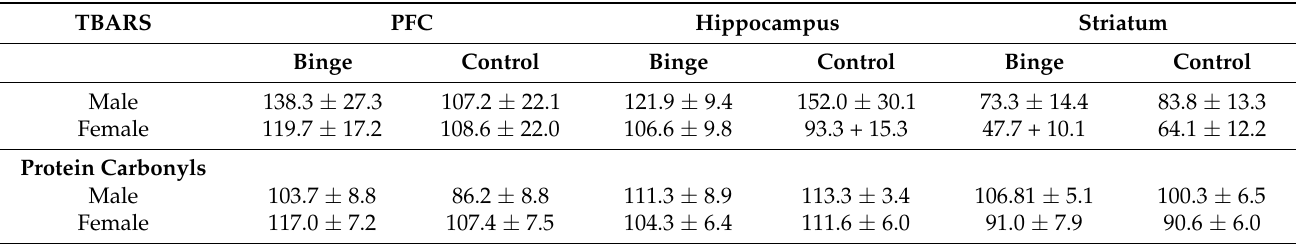
Table 2. Measures of lipid peroxidation (TBARS) and protein damage (protein carbonyls) in brain regions of interest in binged and control groups. Data are expressed as % naïve male. TBARS